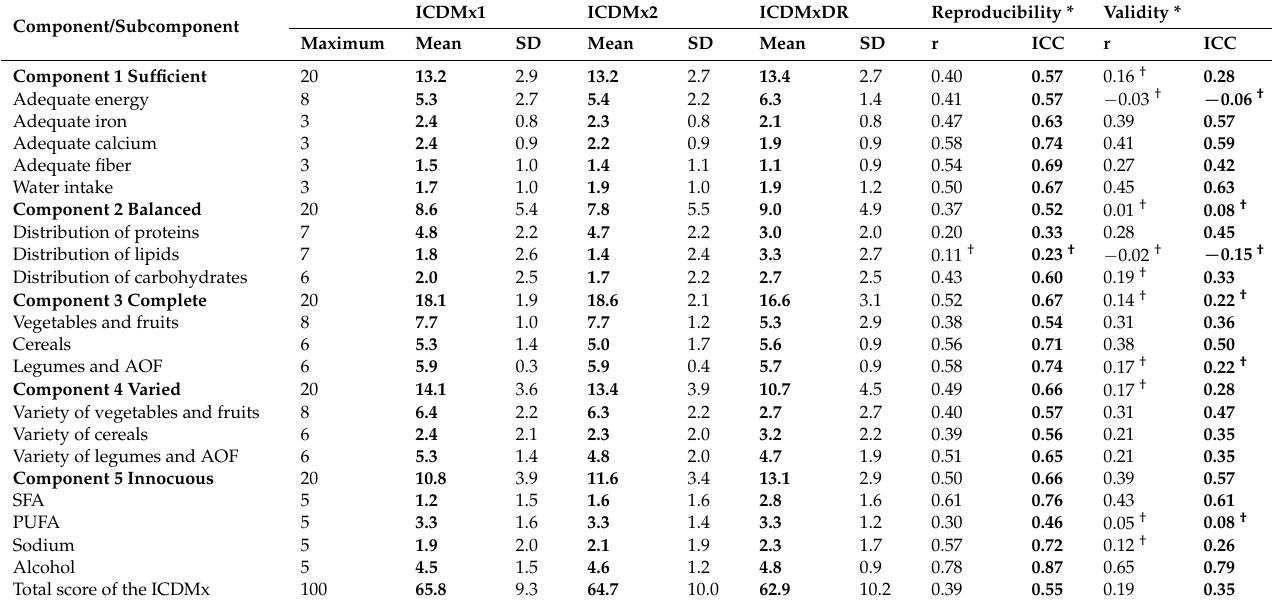
Table 3. Comparison between the ICDMx calculated from the FFQ2, and the average from DRs ( n =